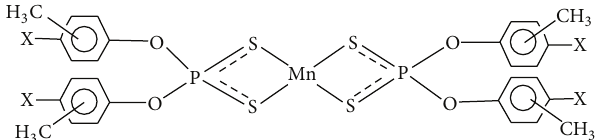
Figure 6: Proposed square planar structure of bis- O,O 󸀠 -( o-, m-, p- and p- Cl -m- ditolyl)dithiophosphates of manganese(II) ( 1 – 4 ); X = H, CH 3 , or Cl.